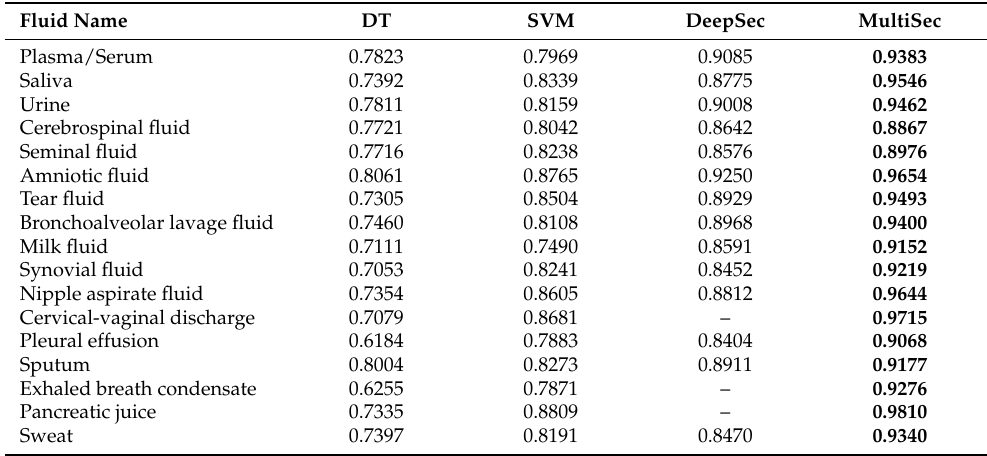
Table A6. AUC benchmarks of MultiSec and compared methods on the independent testing datasets of 17 human body